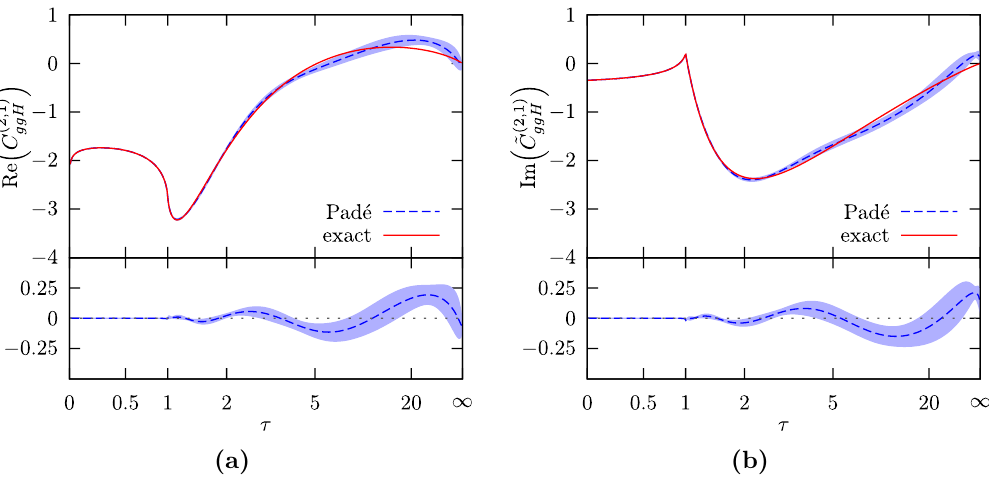
Figure 4 . Real and imaginary part of ~ C (2 ; 1) with the quark mass renormalized on-shell, (cid:22) 2 = ggH M 2 , and the color factors set to their SU(3) values. The red (solid) line is the result given in H (cid:0) eqs. (3.10), (B.4), (B.5). The blue (dashed) line shows the Pad(cid:19)e approximation found in ref. [28]; the associated uncertainty estimate is indicated by the blue shaded band. The lower panel shows the di(cid:11)erence between the Pad(cid:19)e approximation and our